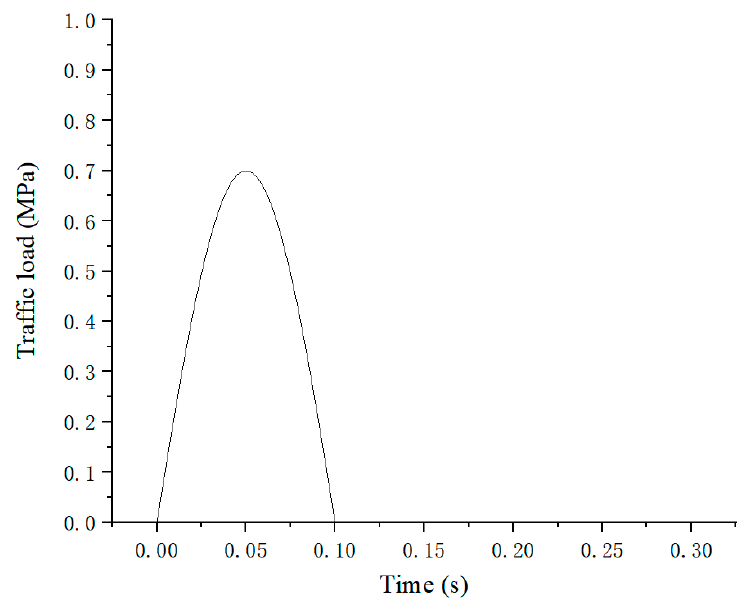
Figure 3. Contact surface between tire and ground.